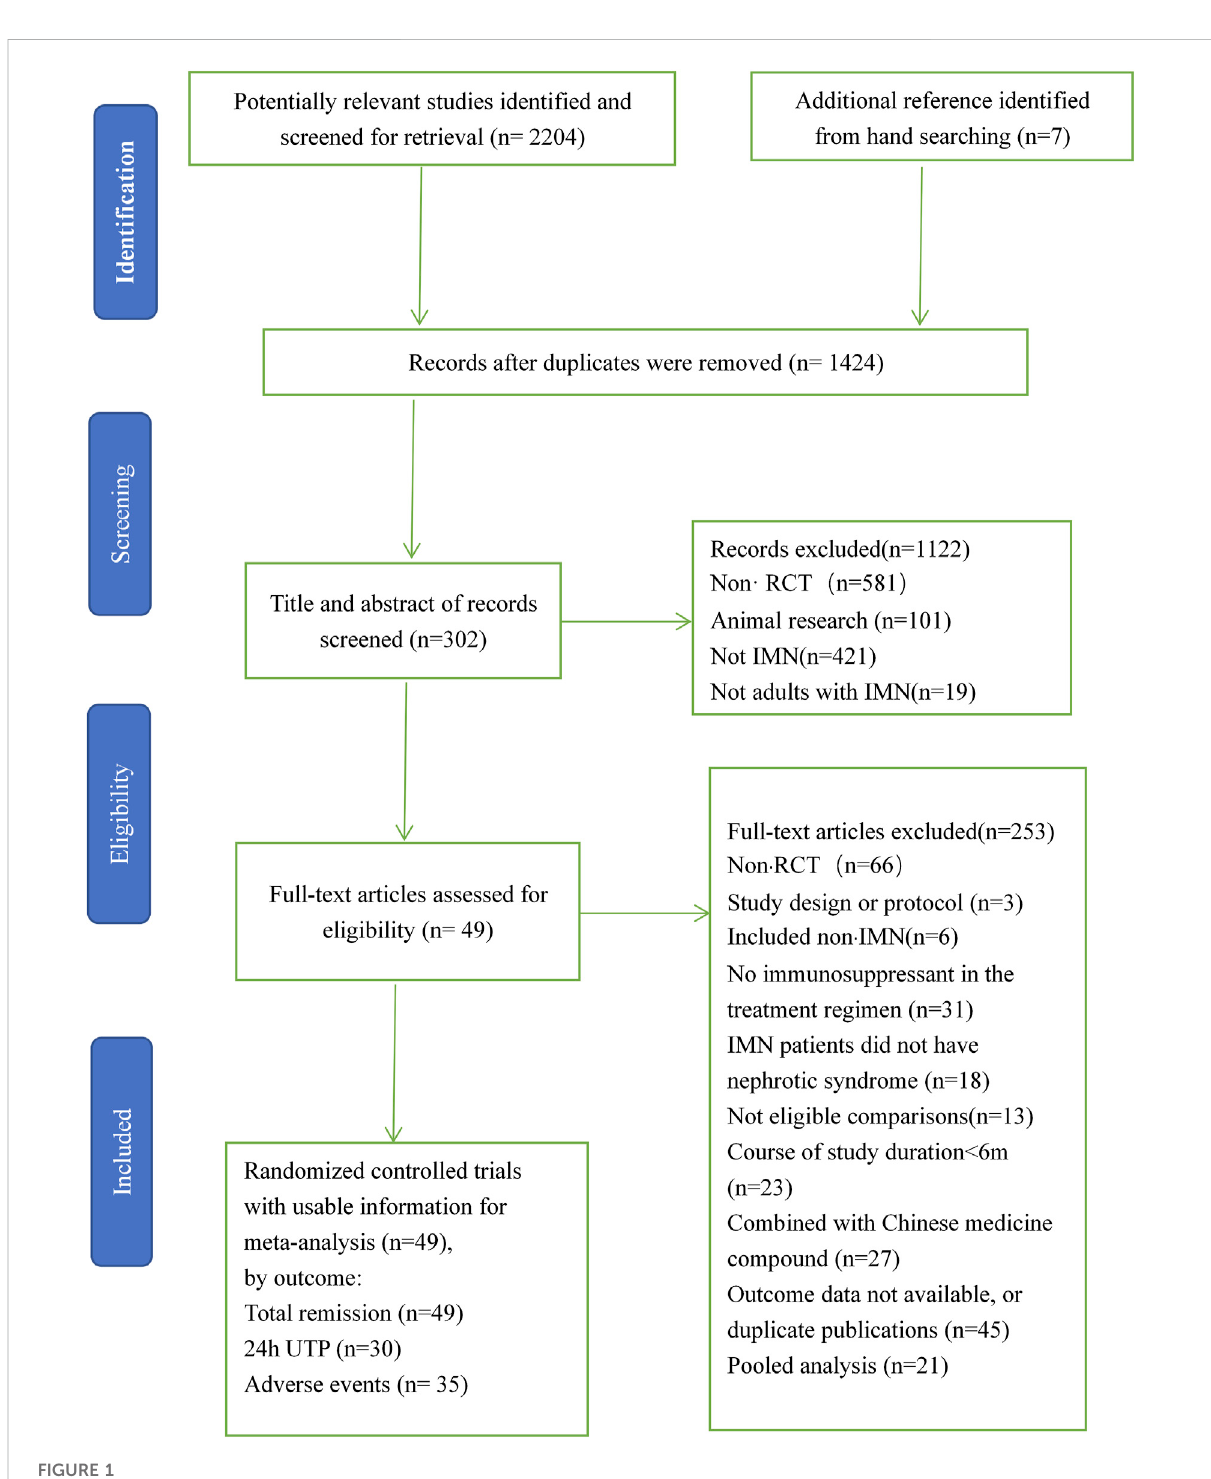
FIGURE 1 Flow chart of literature search and selection. IMN, idiopathic membranous nephropathy; RCTs, randomized clinical trials.